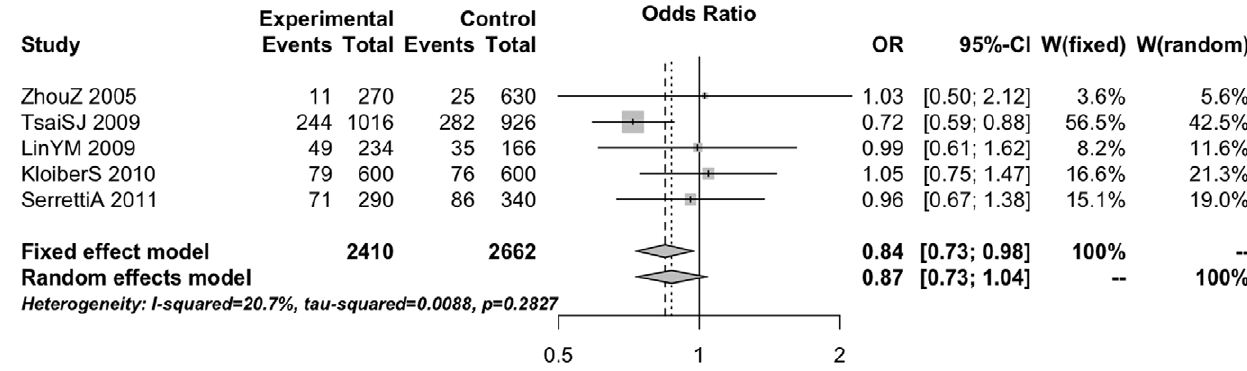
Figure 2. Forest plot of genetic association studies of rs17110747-A and major depression.